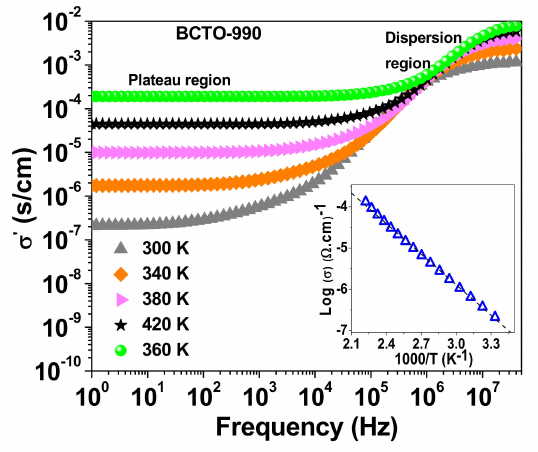
Figure 6. Spectra of AC conductivity at selected temperatures for BCTO ceramics. The inset in each figure shows the Arrhenius plot of DC conductivity. The dotted line represents the line of best fit.